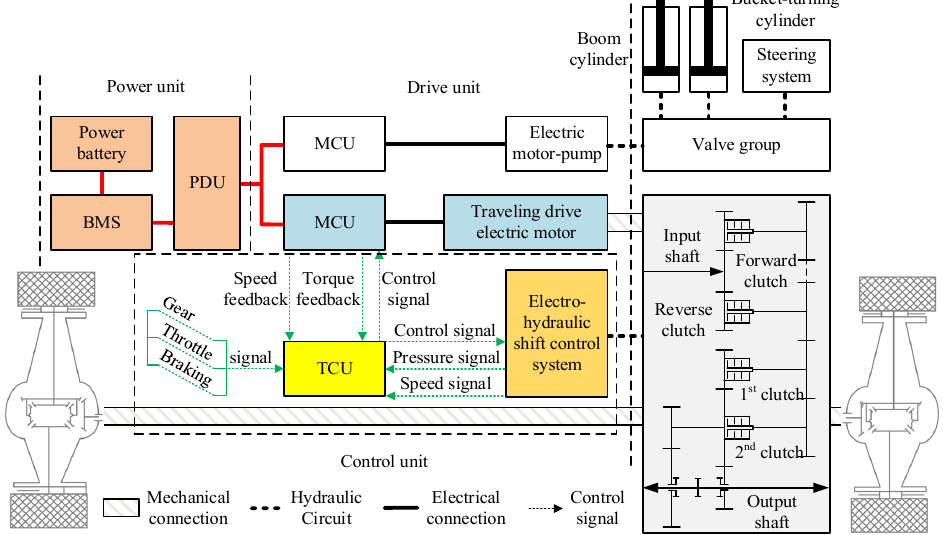
Figure 1. The scheme of a distributed electric motor drive system for a pure electric